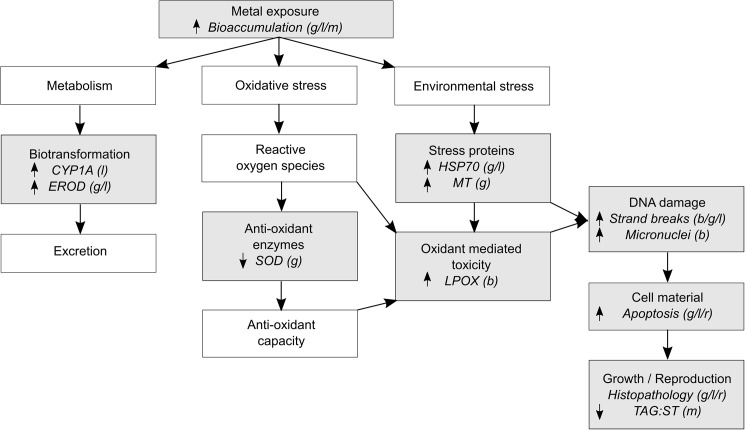
Flow diagram showing chemical, biochemical, physiological and other alterations in response to metal exposure.Biomarkers that have been identified in our systematic review as potentially suitable for fish health assessment in Gladstone Harbour are included in italics. For each biomarker, the arrow presents likely up- or downregulation following metal exposure; suitable tissues are given in between brackets: b = blood, g = gill, l = liver, m = muscle, r = gonads. Modified from [180] in [3].